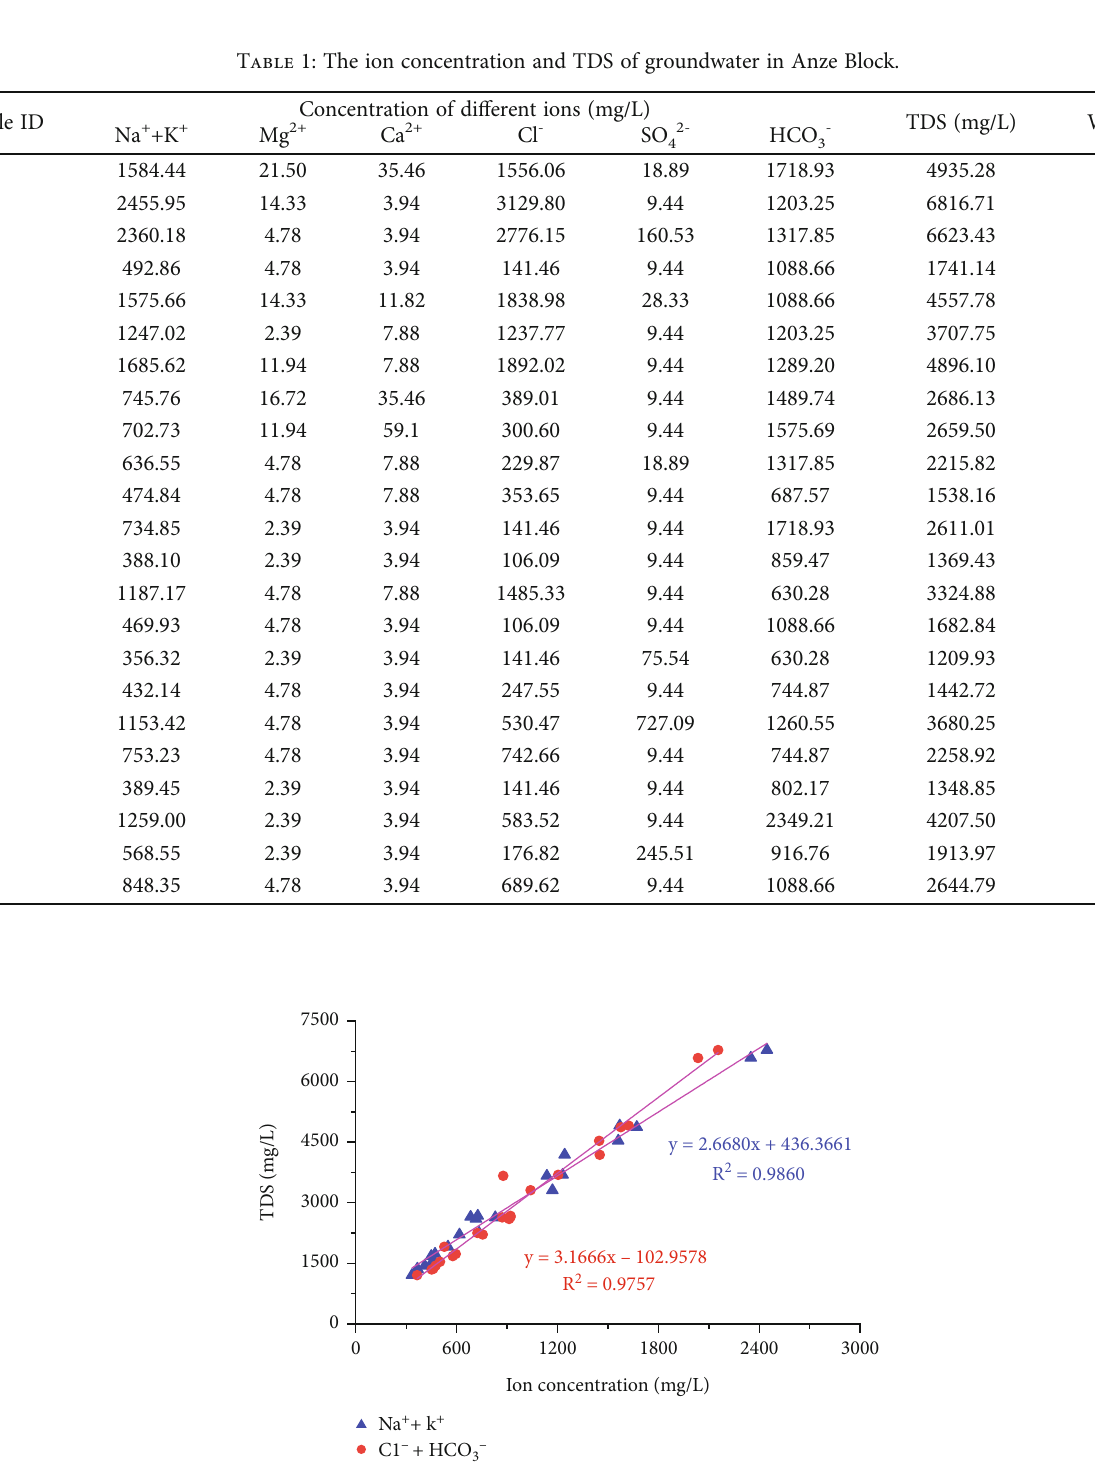
Figure 4: Relationship between Na + +K + and Cl - +HCO 3- concentration and